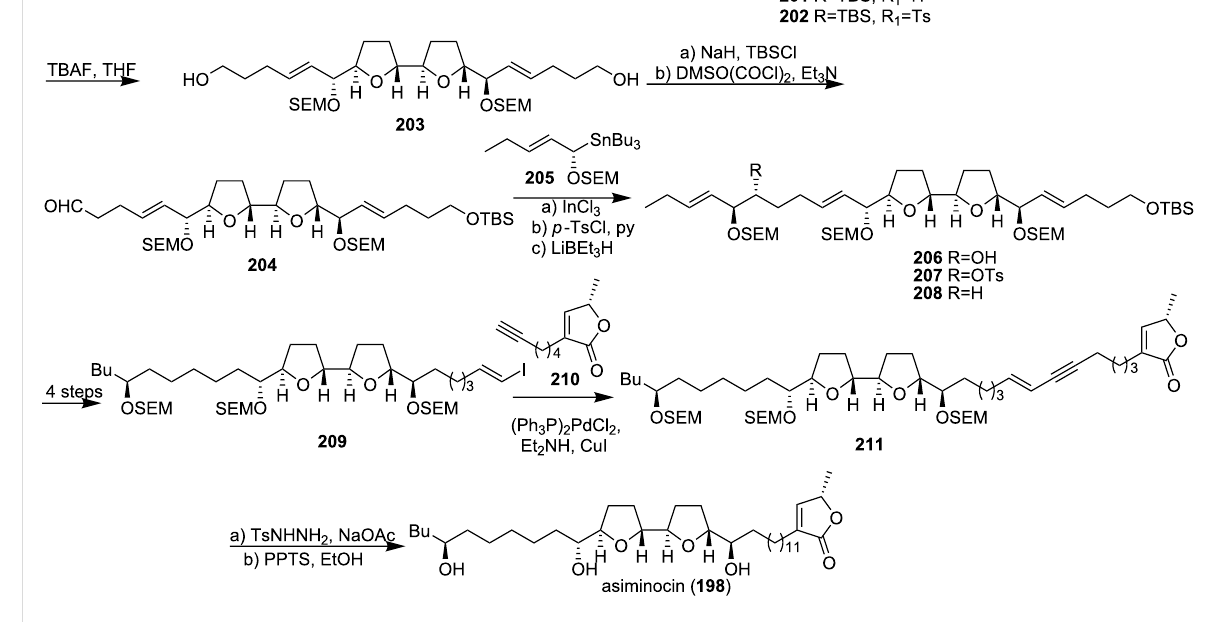
Scheme 27: Total synthesis of asiminocin by Marshall’s group.